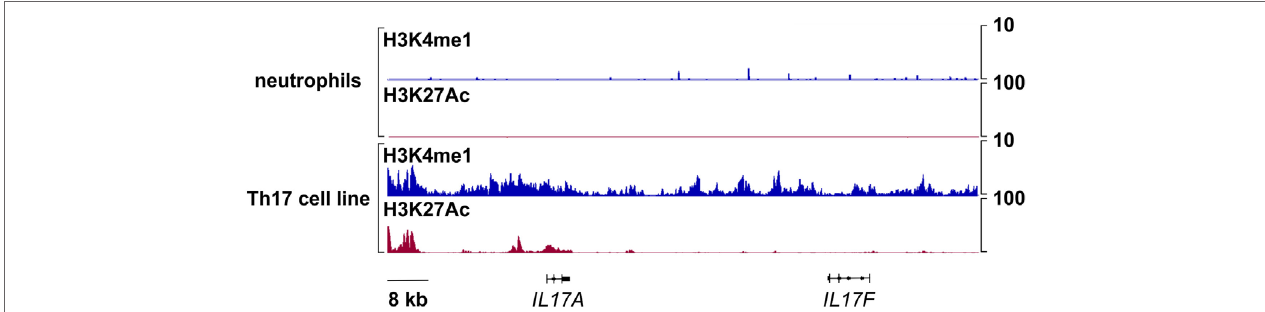
FigUre 5 | Chromatin immunoprecipitation (ChIP)-Seq profiles of H3K4me1 and H3K27Ac at the IL17A and IL17F loci in human neutrophils and Th17 cell lines. Representative snapshots depicting H3K4me1 and H3K27Ac ChIP-seqs at the IL17A and IL17F genomic loci in freshly isolated human neutrophils or, as retrieved from NIH Epigenomics Roadmap Initiative (72), in phorbol mysistate acetate/ionomycin-stimulated Th17 cell